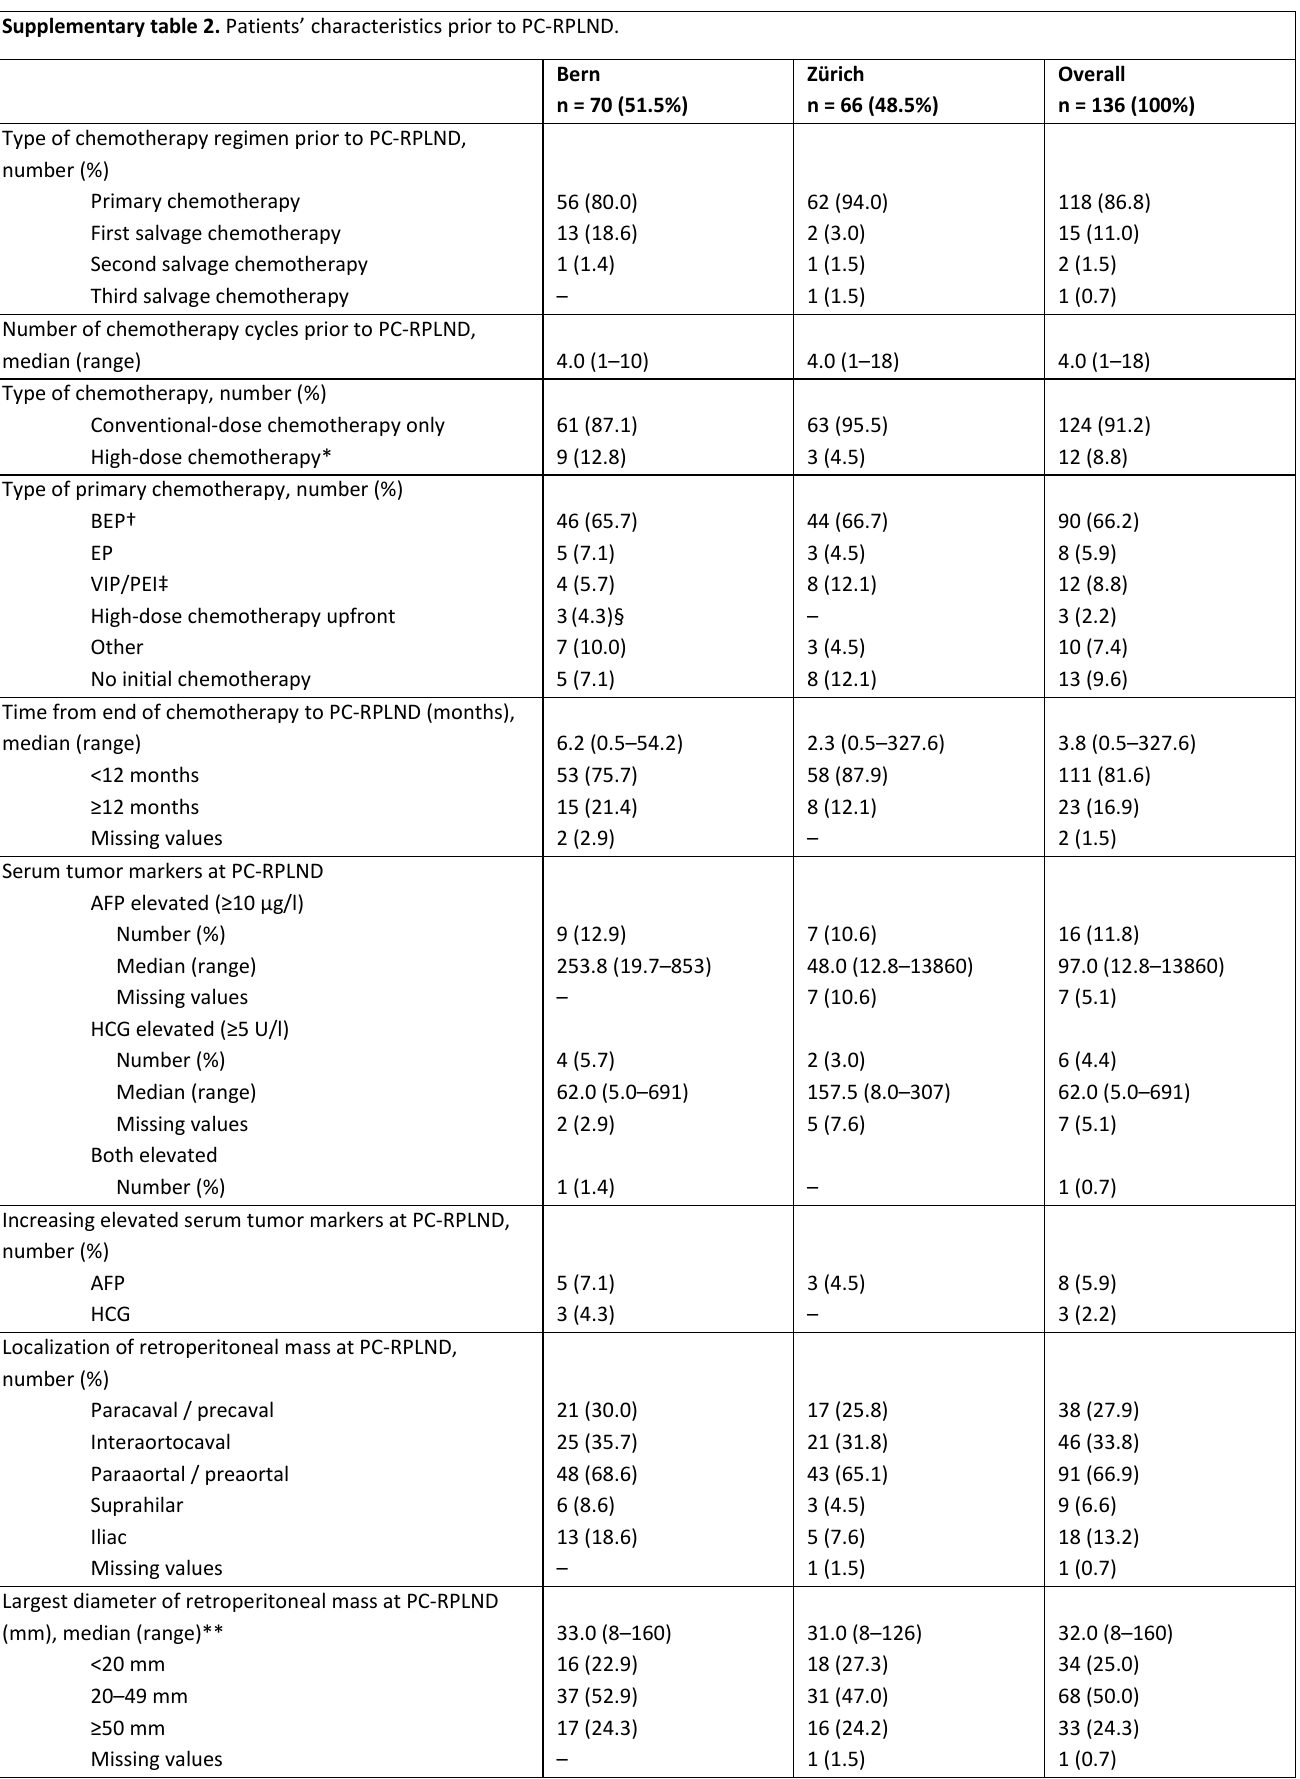
Supplementary table 2. Patients’ characteristics prior to